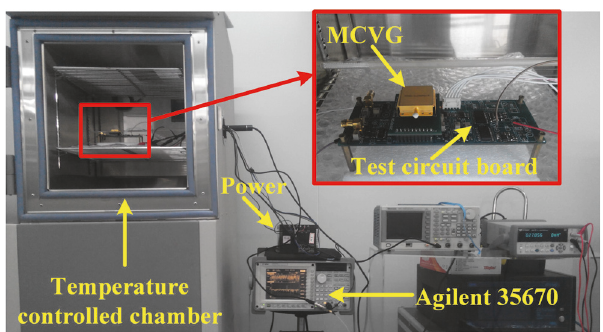
Figure 13: Test system of Q